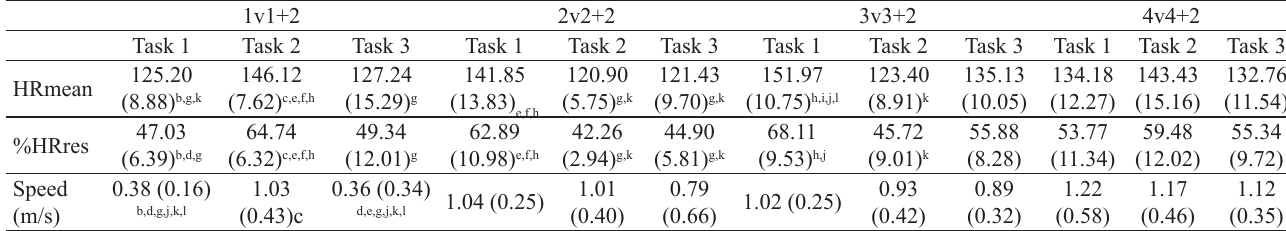
4. Descriptive table (mean and standard deviation) and statistical comparison between crossing factors (game